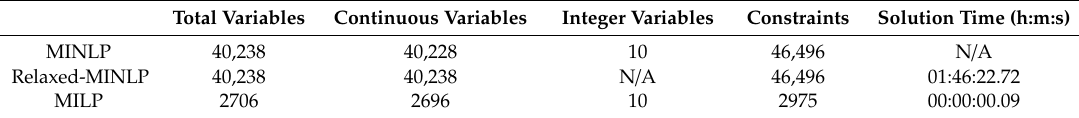
Table 10. Computational and model statistics for the U.S.